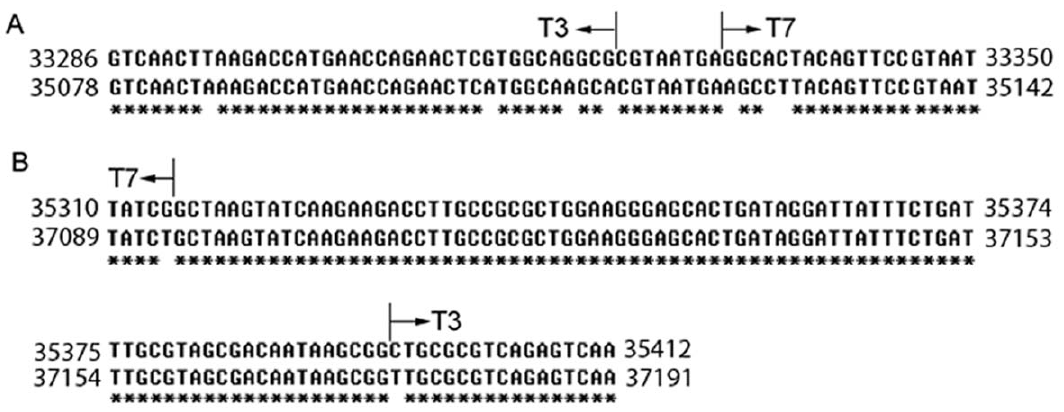
Figure 2. Alignment of T3 and T7 sequences near the crossover regions seen in the T3/7 phage. (A) Within gene 17 . (B) Within gene 18.5 . Sequences were aligned by ClustalW. The parent phages of the two sides of the crossover region (shown by arrows) are indicated on top of the alignment.